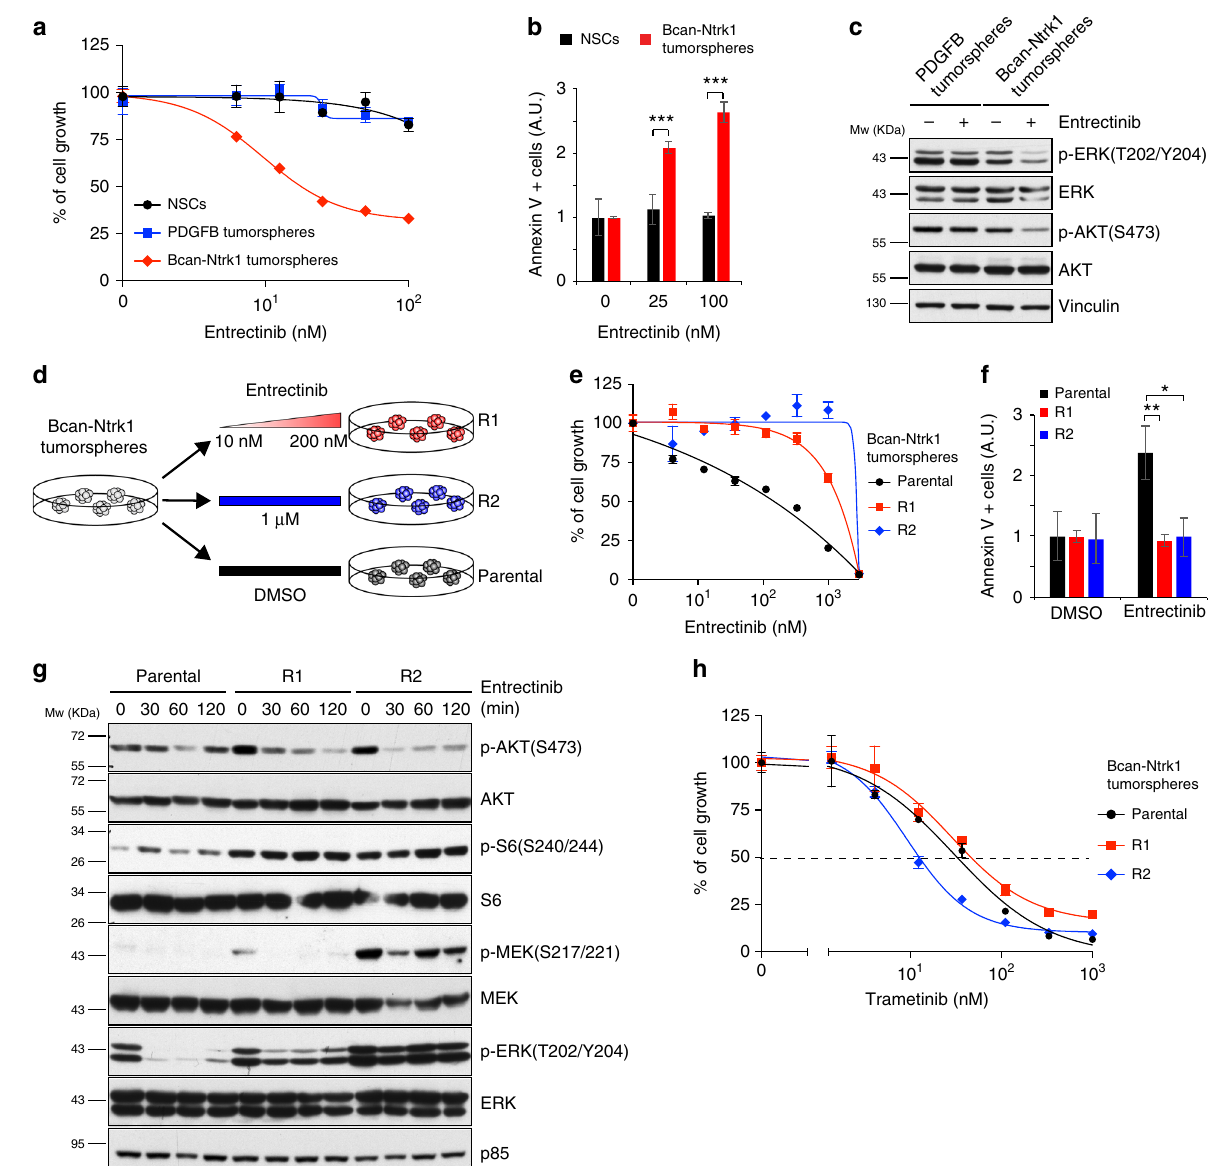
Fig. 5 Bcan-Ntrk1-induced gliomas develop resistance to the TRK inhibitor entrectinib. a Cell proliferation assay performed on p53-null TVA-Cas9 NSCs, Bcan-Ntrk1 or PDGFB tumorspheres exposed for 96 h to increasing doses of entrectinib, a pan-TRK inhibitor. b Entrectinib treatment in Bcan-Ntrk1 tumorspheres induces an increase in apoptosis, as measured by Annexin V-positive cells, 48 h after treatment. Data from a representative of two experiments are presented as mean ± SD ( n = 3); Student ’ s t test: *** P < 0.001; A.U. arbitrary unit. c Western blot analysis using the speci fi ed antibodies on Bcan-Ntrk1 or PDGFB tumorspheres grown for overnight in absence of growth factors and then treated with entrectinib (1 μ M) for 16 h. d Schematic representation of the generation of entrectinib-resistant cell lines (see text for details). e Cell proliferation assay performed on parental Bcan-Ntrk1, R1 and R2 tumorspheres exposed for 96 h to increasing doses of entrectinib. f Absence of apoptosis induction in entrectinib-resistant cells, as measured by Annexin V-positive cells, 72 h after entrectinib treatment (100 nM). Data from a representative of two experiments are presented as mean ± SD ( n = 3); Student ’ s t test: ** P < 0.005, * P < 0.05; A.U. arbitrary unit. g Western blot analysis using the speci fi ed antibodies on parental Bcan-Ntrk1, R1 and R2 tumorspheres treated with entrectinib (1 μ M) for the indicated timepoint. h Cell proliferation assay performed on parental Bcan-Ntrk1, R1 and R2 tumorspheres exposed for 96 h to increasing doses of